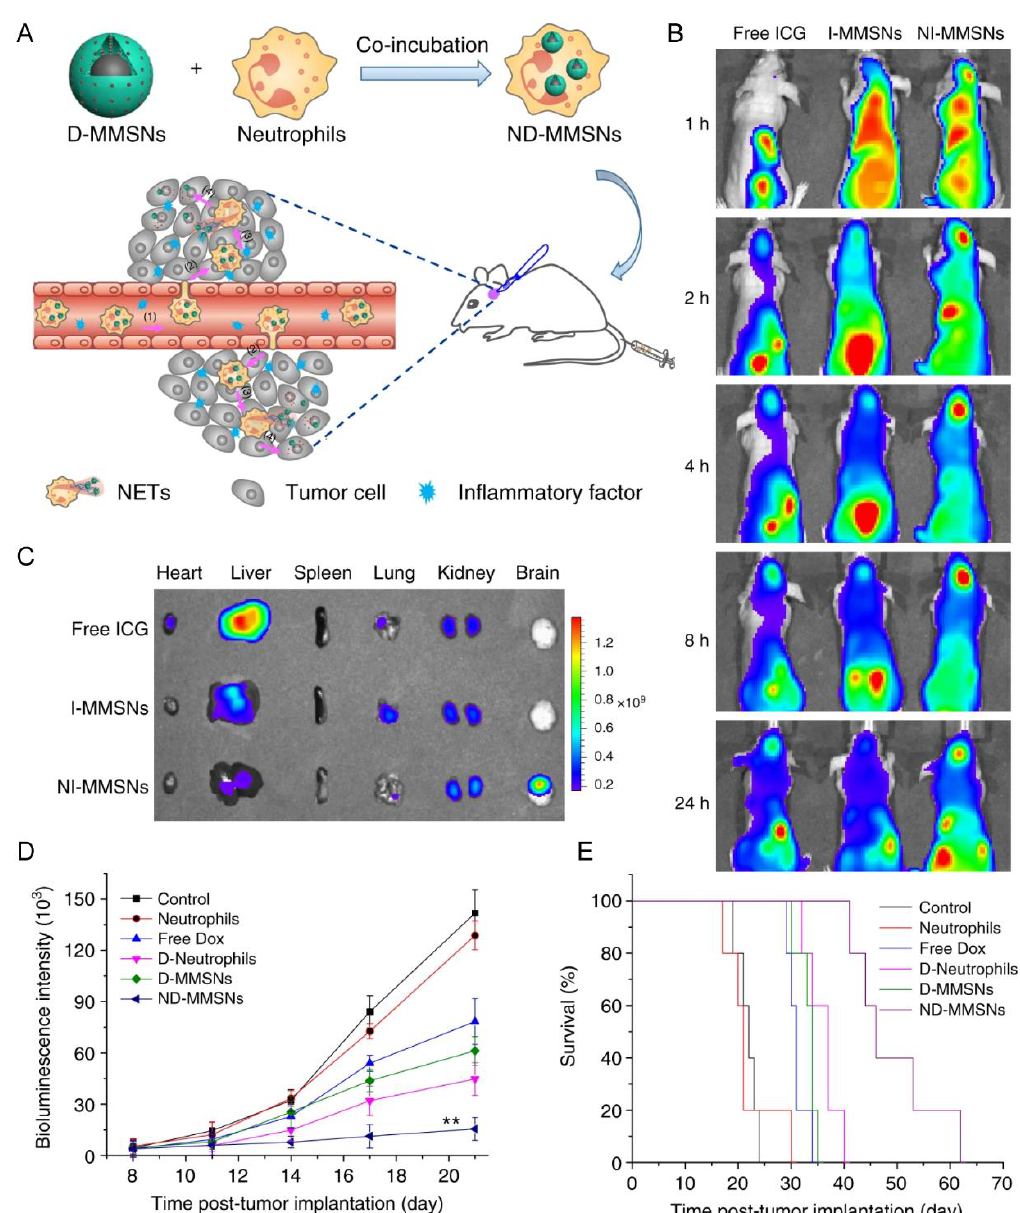
Figure 3. ( A ) Schematic synthesis of the ND-MMSNs for targeting the inflamed glioma sites. ( B ) In vivo fluorescence images of U87 glioma-bearing mice after intravenous administration of NI-MMSNs (I, near-infrared dye indocyanine green (ICG)). ( C ) Ex vivo fluorescent images of major organs. ( D ) In vivo therapeutic efficacy and ( E ) survival curves of ND-MMSNs in mice bearing